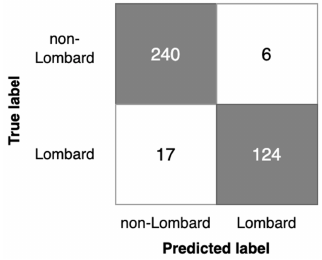
Figure 8. Confusion matrix for the G1 model.